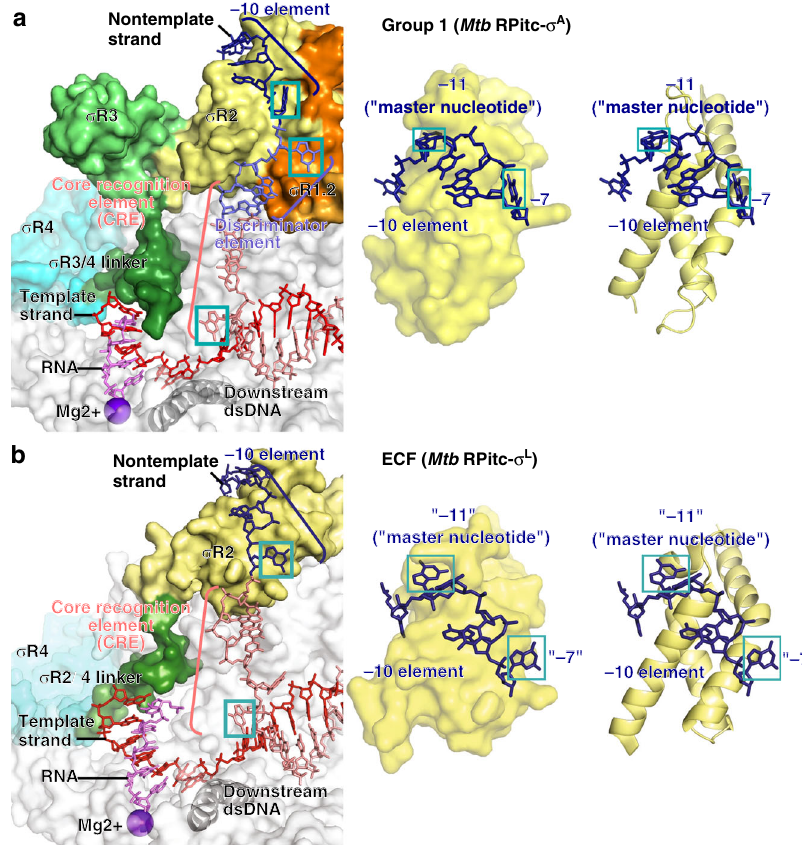
Fig. 4 Protein – nucleic acid interactions by group-1 and ECF σ factors: interactions with transcription bubble. a Left: interactions of Mtb RNAP and σ A with transcription-bubble nontemplate strand, transcription-bubble template strand, and downstream dsDNA. Right: interactions of σ A σ R2 with σ A -dependent promoter -10 element. For promoter positions -11 ( “ master nucleotide ” ) 40 and -7, bases are unstacked and inserted into pockets (cyan boxes). Colors are as in Figs. 1 – 3. b Left: interactions of Mtb RNAP and σ L with transcription-bubble nontemplate strand, transcription-bubble template strand, and downstream dsDNA. Right: interactions of σ L σ R2 with σ L -dependent promoter -10 element. For two promoter positions, here designated “ -11 ” ( “ master nucleotide ” ) and “ -7 ” , by analogy to corresponding nucleotides in group-1- σ -factor complex (panel a ), bases are unstacked and inserted into pockets (cyan boxes). For one additional nucleotide, here designated “ -12 ” , the base also appears to be unstacked and inserted into a pocket (dashed cyan box). See Supplementary Figs. 4, 5 and